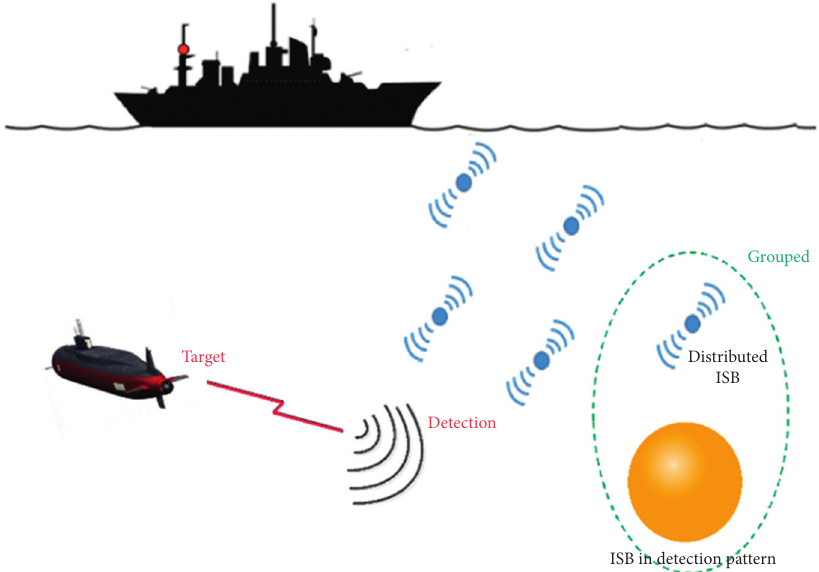
Figure 10: An application scenario of the Hybrid ECOD Method.